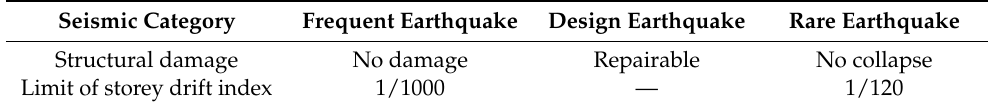
Table 4. Design details of the seismic performances under three seismic